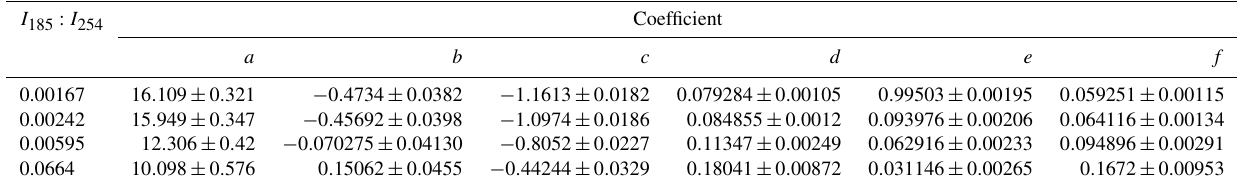
Table 2. OH exp estimation equation coefficients ( ± 1 σ ) as defined in Eq. (1).